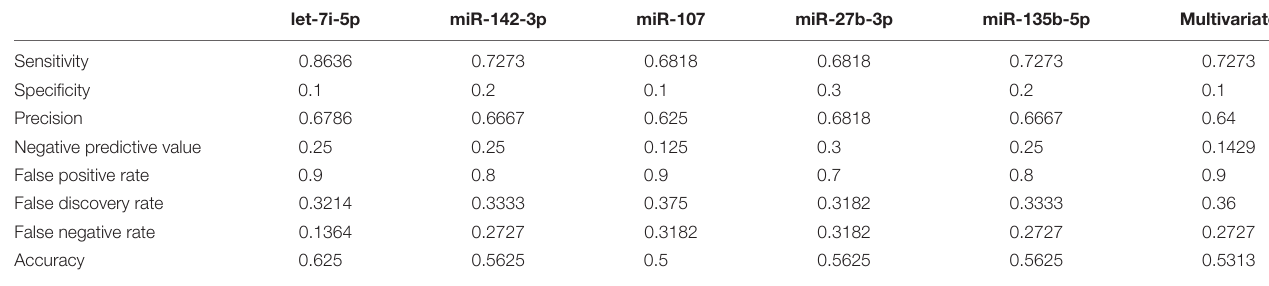
TABLE 2 | Comparison of performances of univariate and multivariate ROC